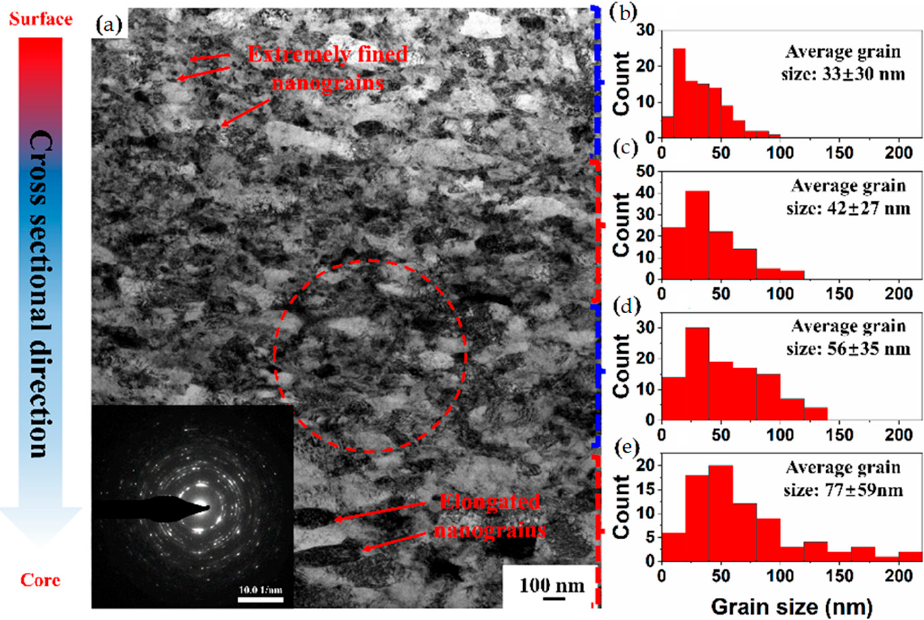
Figure 3. Characterizations of the gradient nanograined 316L stainless steel subjected to the ultrasonic shot peening process: ( a ) Bright-field transmission electron microscope (TEM) characterization of the as-fabricated gradient nano-grained 316L stainless steel. The inset is the diffraction pattern for the area circled by the red dashed line. The average grain size of the gradient nano-grained structure at different locations can be seen in ( b – e ).